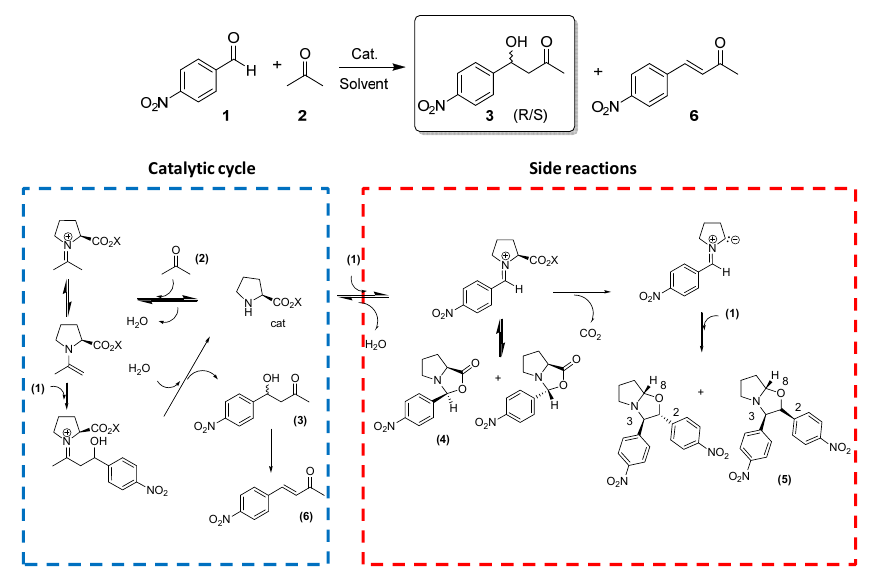
Figure 4. Benchmark aldol reaction between p -nitrobenzaldehyde ( 1 ) and acetone ( 2 ). General mechanisms for the formation of aldol and side products in the aldol reaction catalyzed by L -proline derivatives (adapted from Ref. [38]). Table 1. Results for the aldol reaction between p -nitrobenzaldehyde and acetone with different imidazolium L -prolinates (40% catalyst loading) at room temperature in toluene 1 .